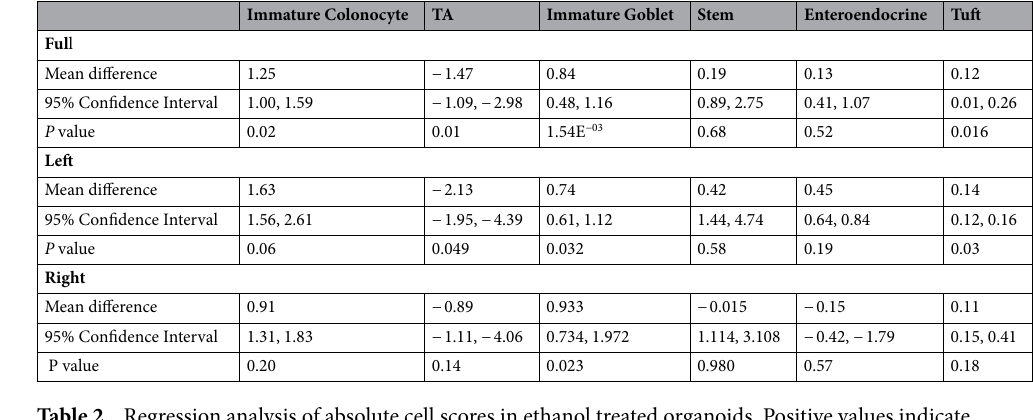
Table 2. Regression analysis of absolute cell scores in ethanol treated organoids. Positive values indicate increased absolute cell score in vehicle control colon organoids.